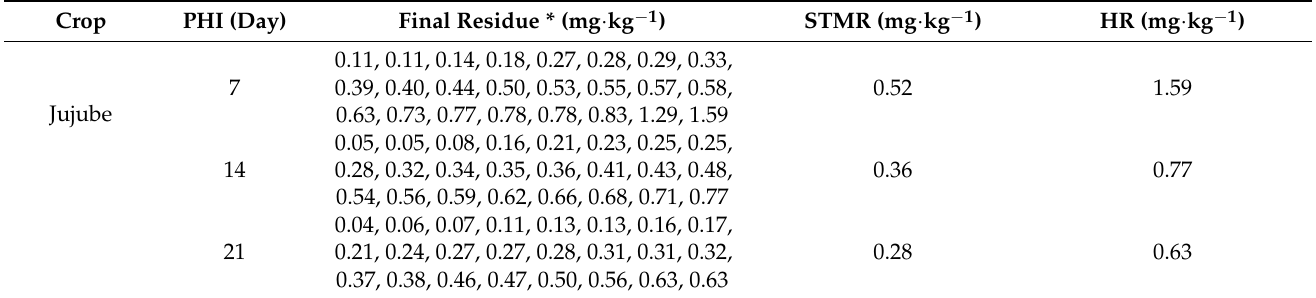
Table 4. Summary of final residues.